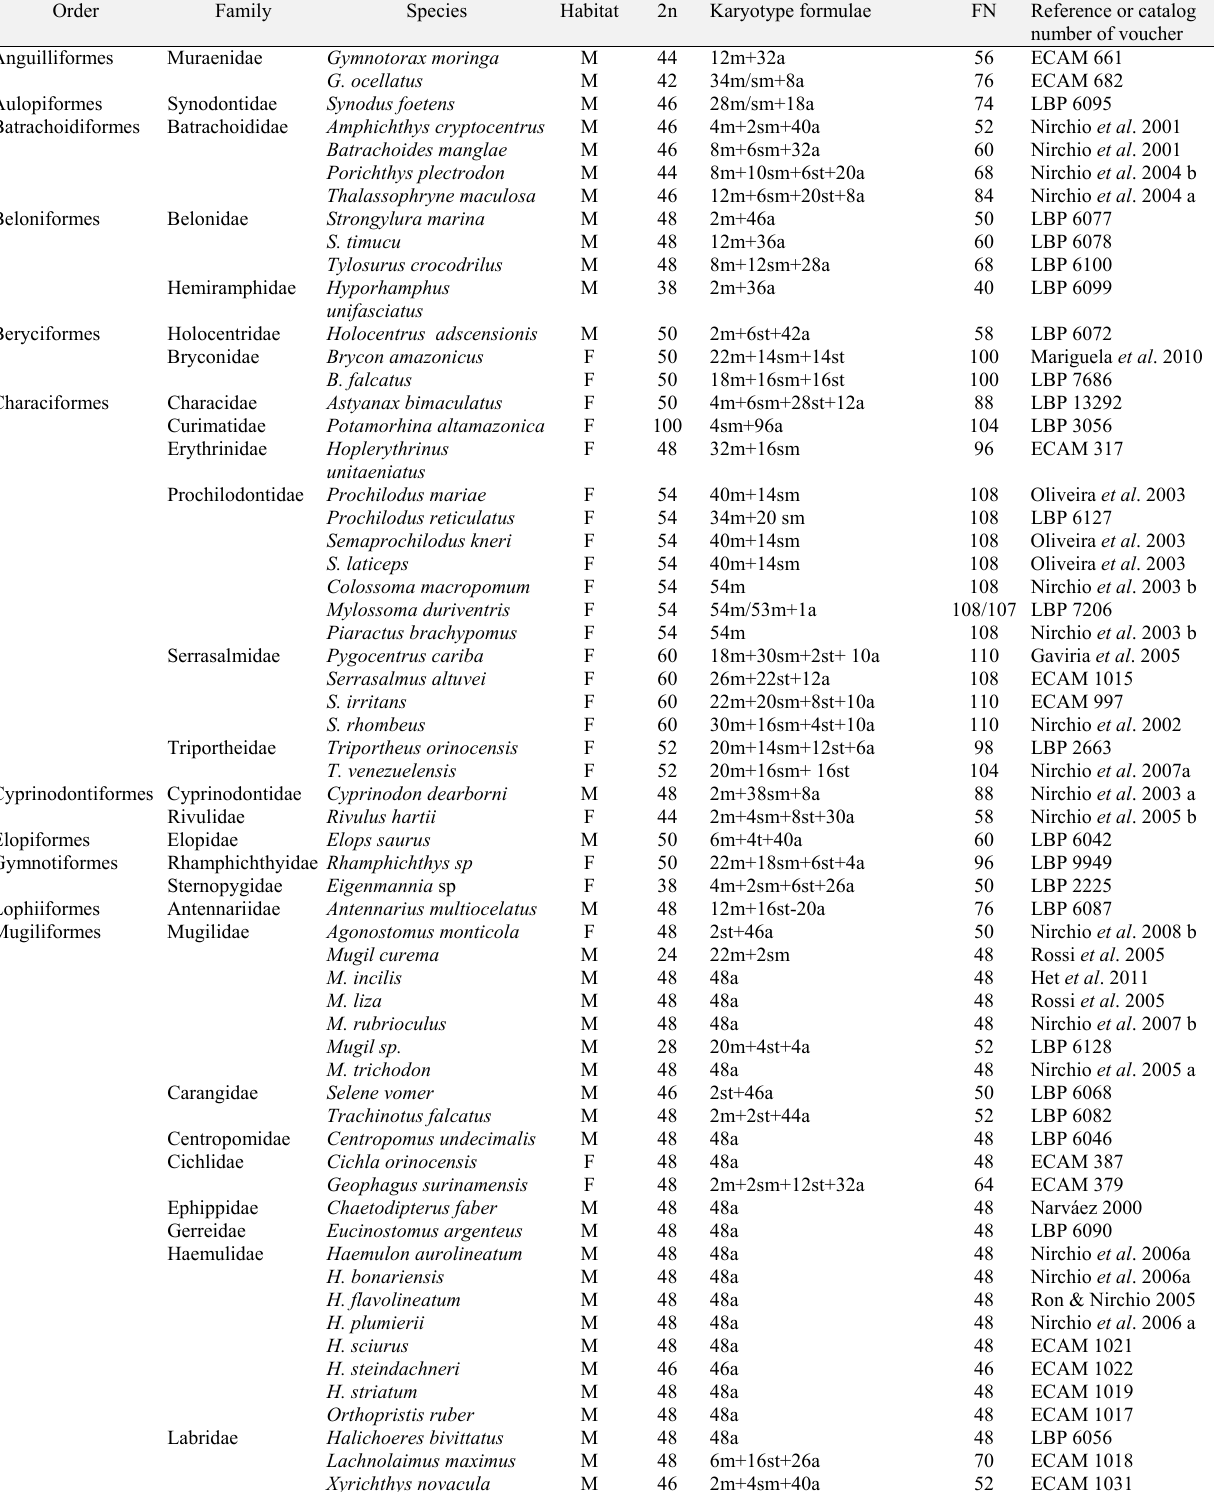
Table 2. Karyotype characteristics for 103 species of fishes from Venezuela. M = marine, F = freshwater, m= meta-, sm = submeta-, st = subtelo- and a = acrocentric chromosomes. In the last column the catalog numbers of the voucher specimens of species whose results are firstly presented here. Classification follows Eschmeyer & Fong